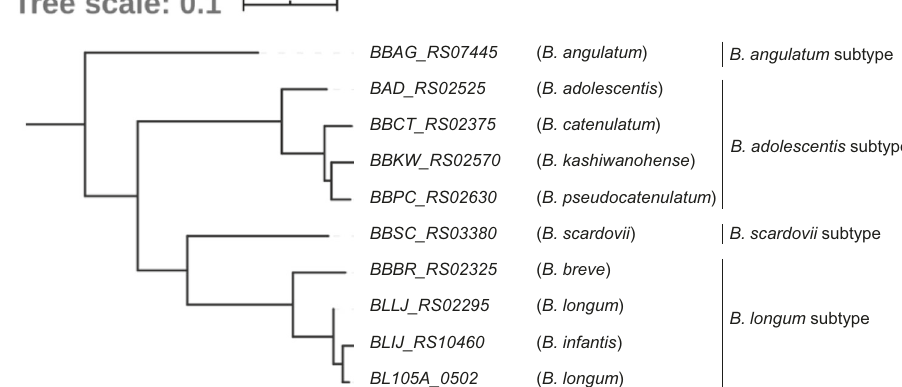
Fig. 4 Phylogenetic tree of BL105A_0502 homologues present in lactulose-assimilating Bi fi dobacterium genomes. The tree was constructed using the amino acid sequences of BL105A_0502 homologues (e-value threshold <10 − 100 ) from 10 Bi fi dobacterium genomes with the lactulose-assimilation phenotype (see Fig. 3). The locus tag number of each Bi fi dobacterium genomes (parenthesised) and the phylogeny-based SBP subtype classi fi cation are